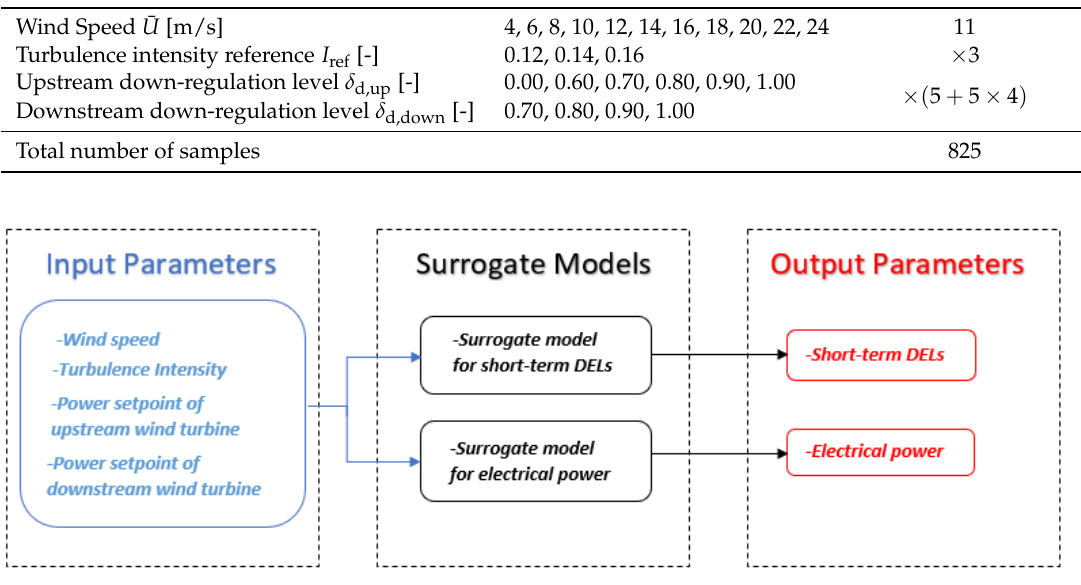
Figure 1. General schematic diagram of surrogate